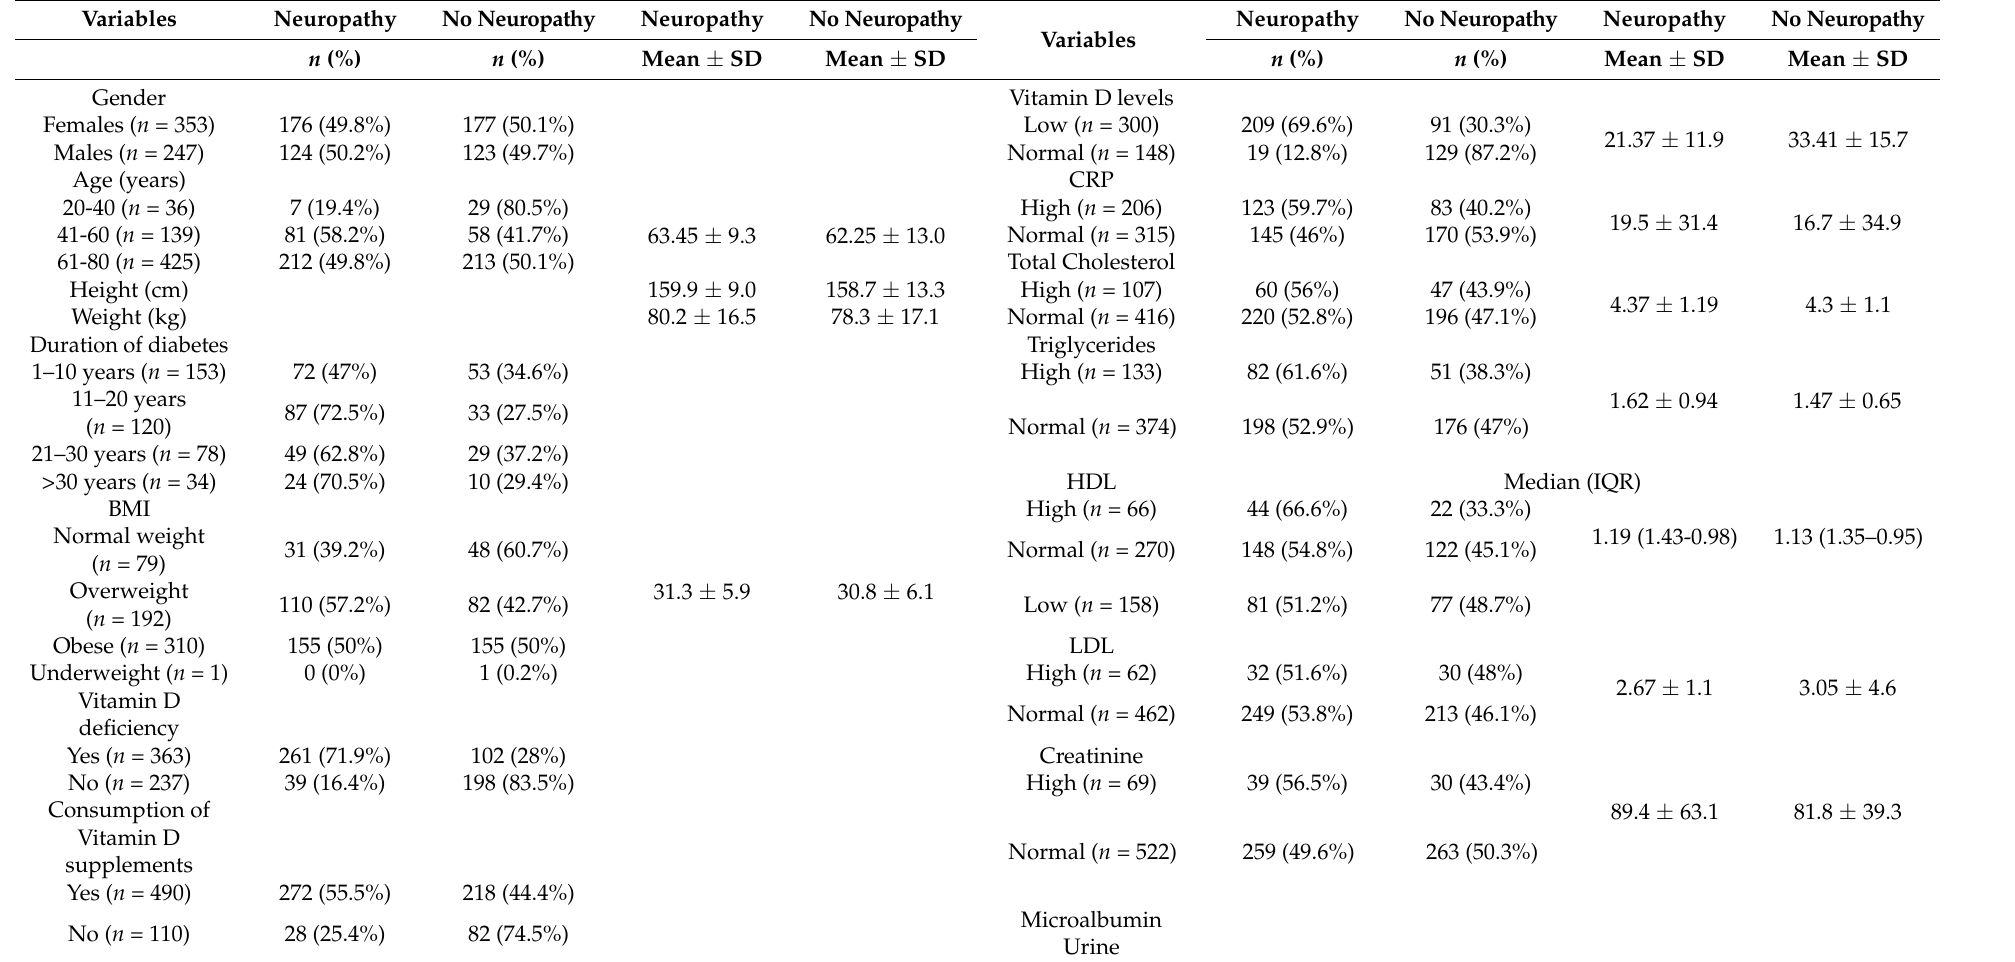
Table 2. Comparison of anthropometric characteristics, clinical characteristics and Vitamin D supplement consumption of patients between group 1 (neuropathy) and group 2 (no